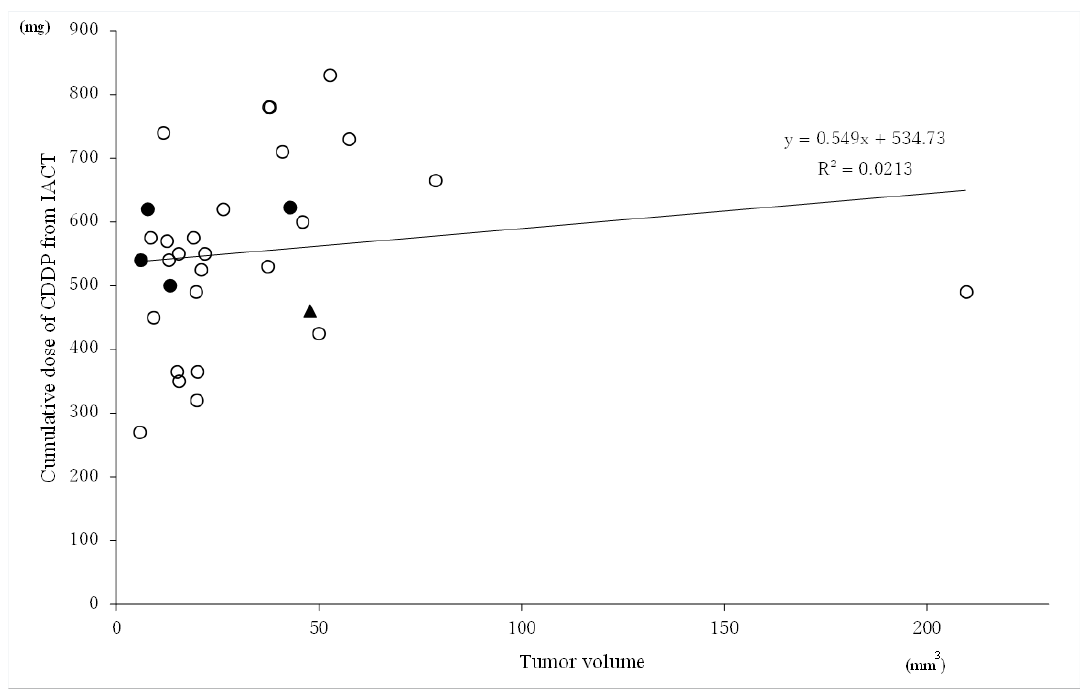
Figure 4. Scatter plot showing the tumor volume and total cumulative dose of CDDP administered with intra-arterial chemotherapy (IACT). Open circles are local control cases, closed circles are local recurrent cases within the perfusion area of IACT, and the closed triangle is a case of local recurrence outside the perfusion area of IACT. The tumor volume and total dose of CDDP were not correlated.